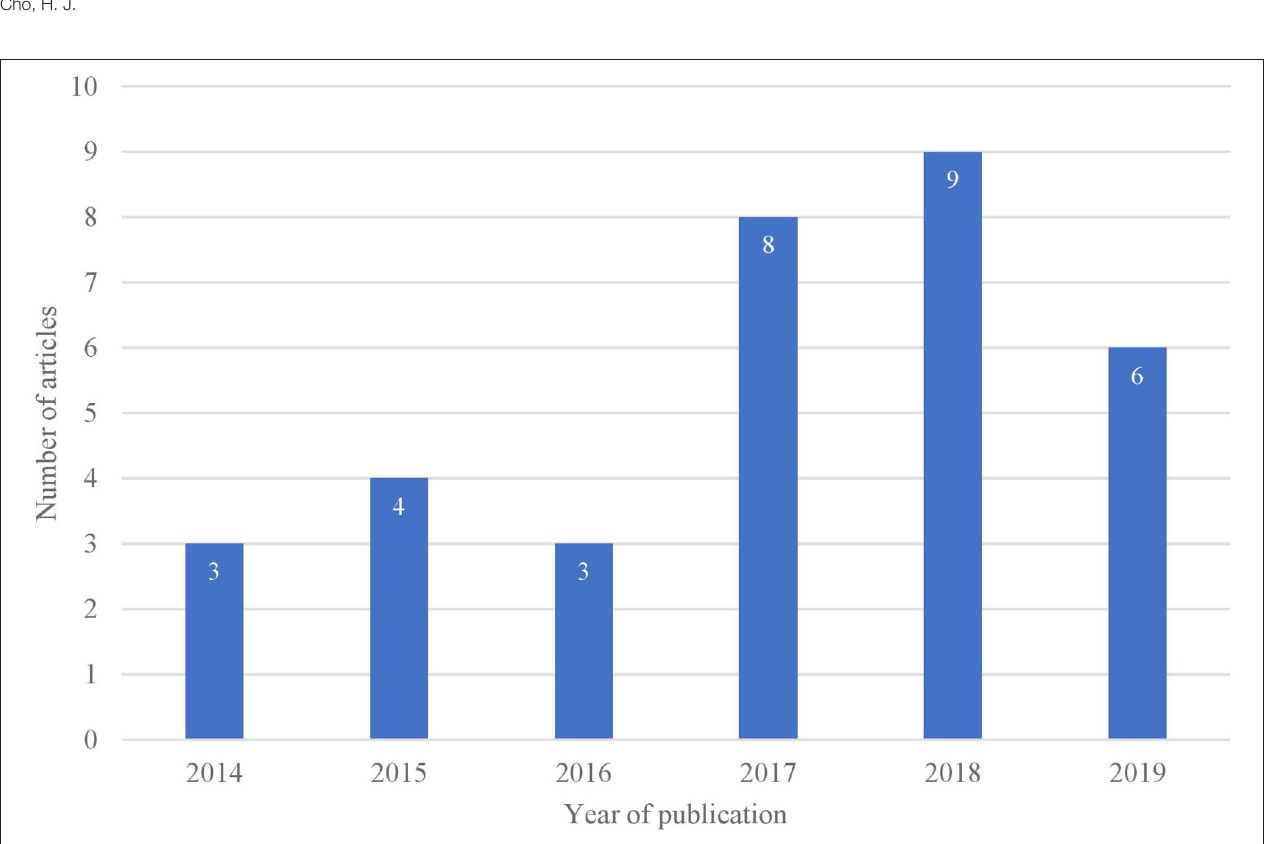
FIGURE 2 | Number of articles published by year.